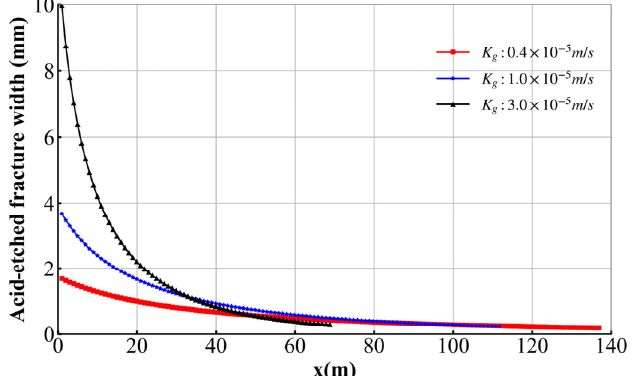
Figure 9. Acid-etched fracture width distribution under constant mass transfer coefficient (without considering the variation in mass transfer coefficient with temperature).